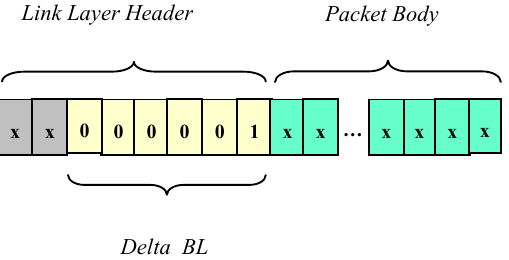
is the 6-bit long data field in the 8-bit Link Layer header.Note that 1_ = BLDelta is set in the figure, which corresponds to the unicast acknowledged